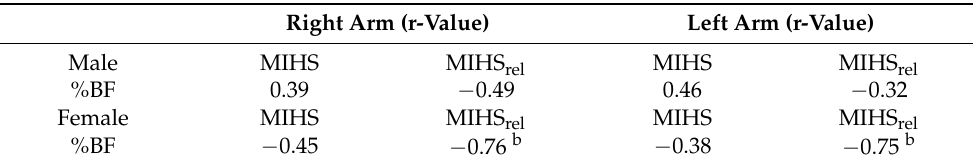
Table 2. Correlation between body fat percentage, maximum isometric, and relative handgrip strength of arm.